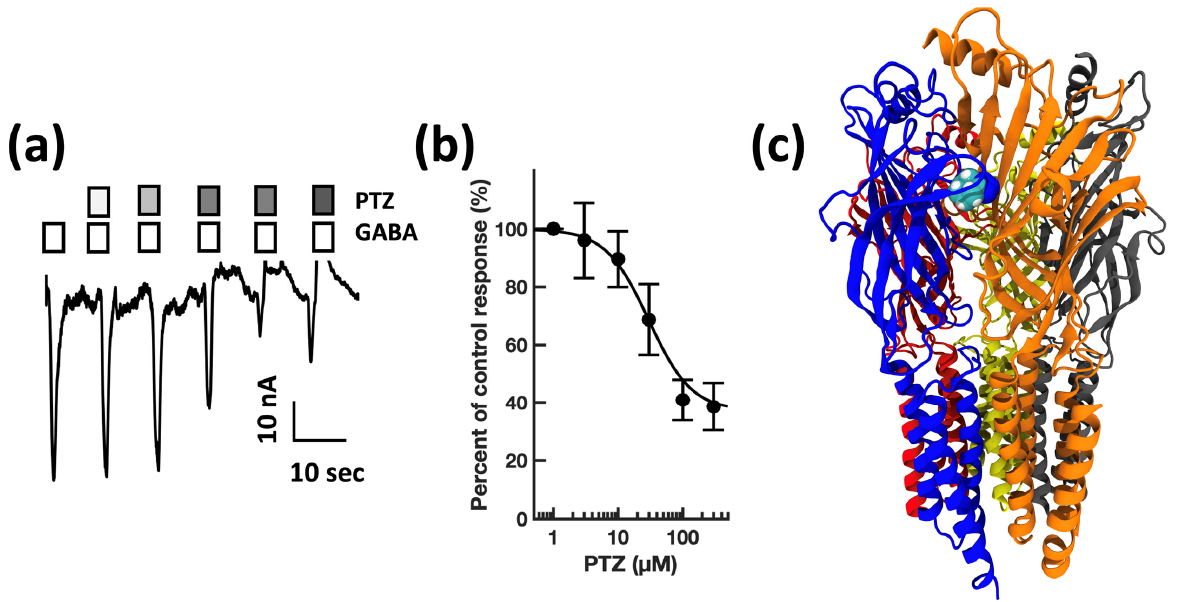
Figure 4. Pentylenetetrazole inhibits GABA A receptor activation in a concentration-dependent manner, and preferentially docks at the γ + β Interface in a pocket defined by canonical loops A–E. ( a ) Representative microfluidic ensemble whole cell recording from HEK293 cells expressing